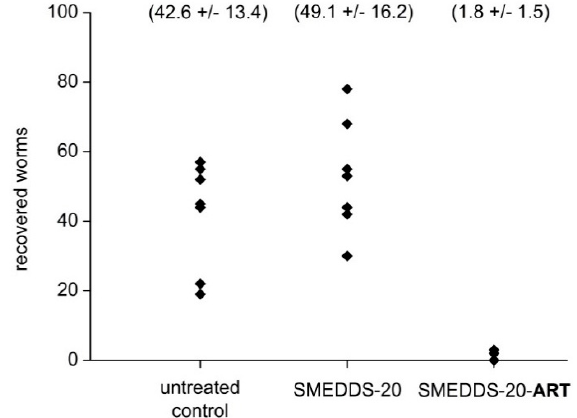
Figure 7. The effect of SMEDDS-20-ART and drug-free SMEDDS-20 administered by gavage on the number of worms in S. mansoni infected mice. Each point represents one mouse ( n = 9 in the untreated and vehicle groups, n = 6 in the artemisone treated group).